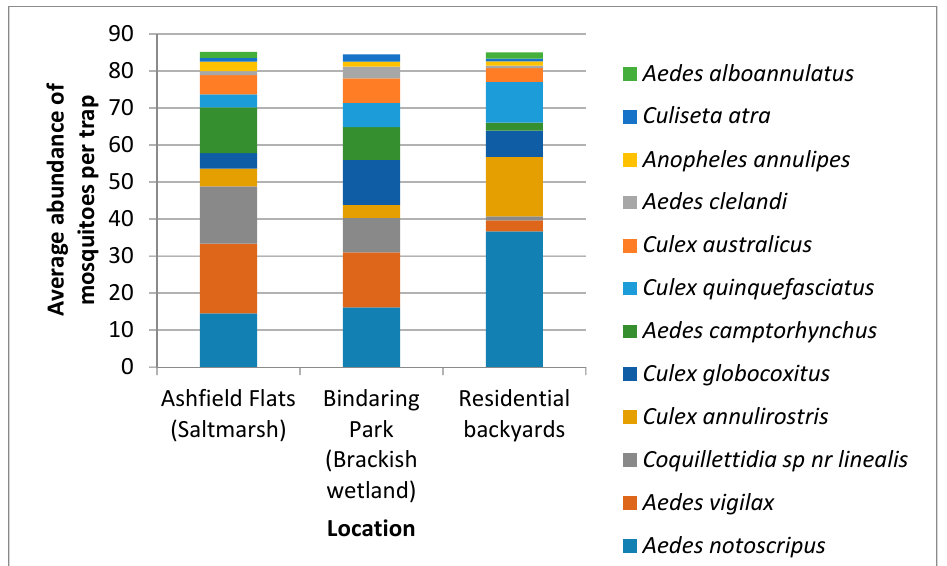
Figure 3. The average abundance of adult mosquitoes collected with EVS CO 2 traps at Ashfield Flats, Bindaring Park and within residential backyards.